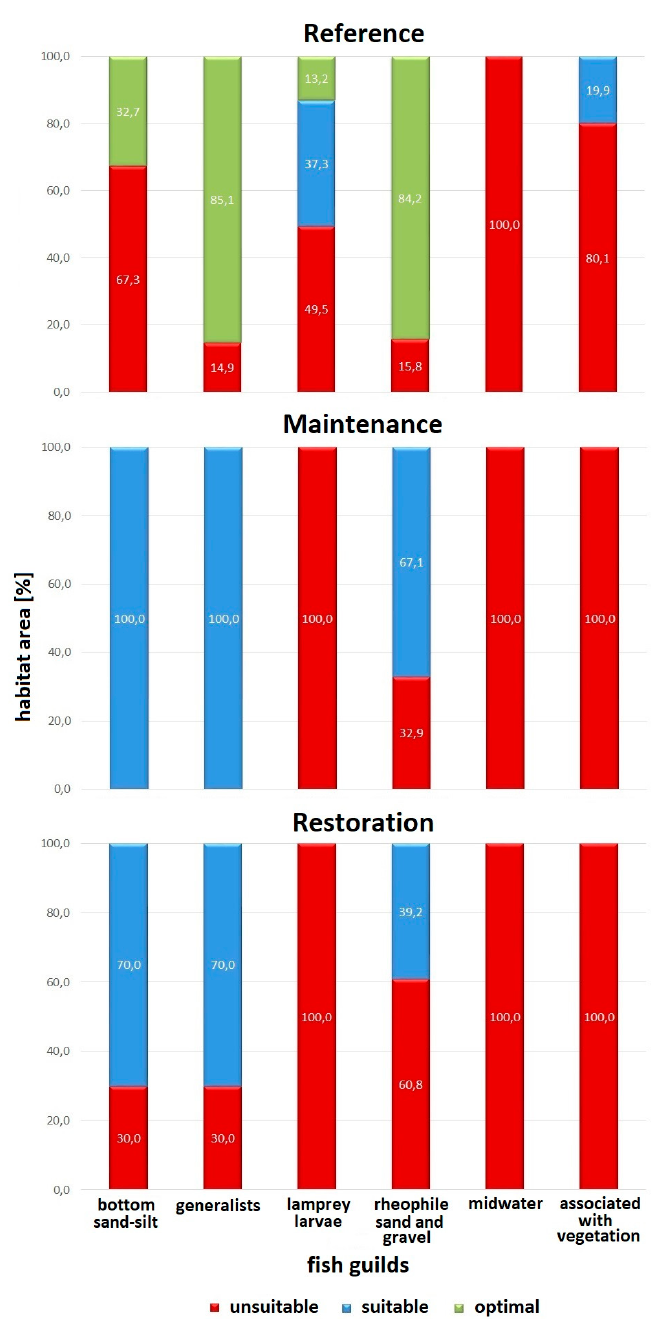
Figure 5. Habitat usability for fish guilds for the reference conditions, after simulated maintenance and restoration works on the Swider river